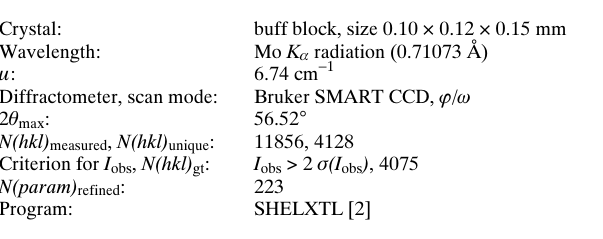
Table 1. Data collection and handling.